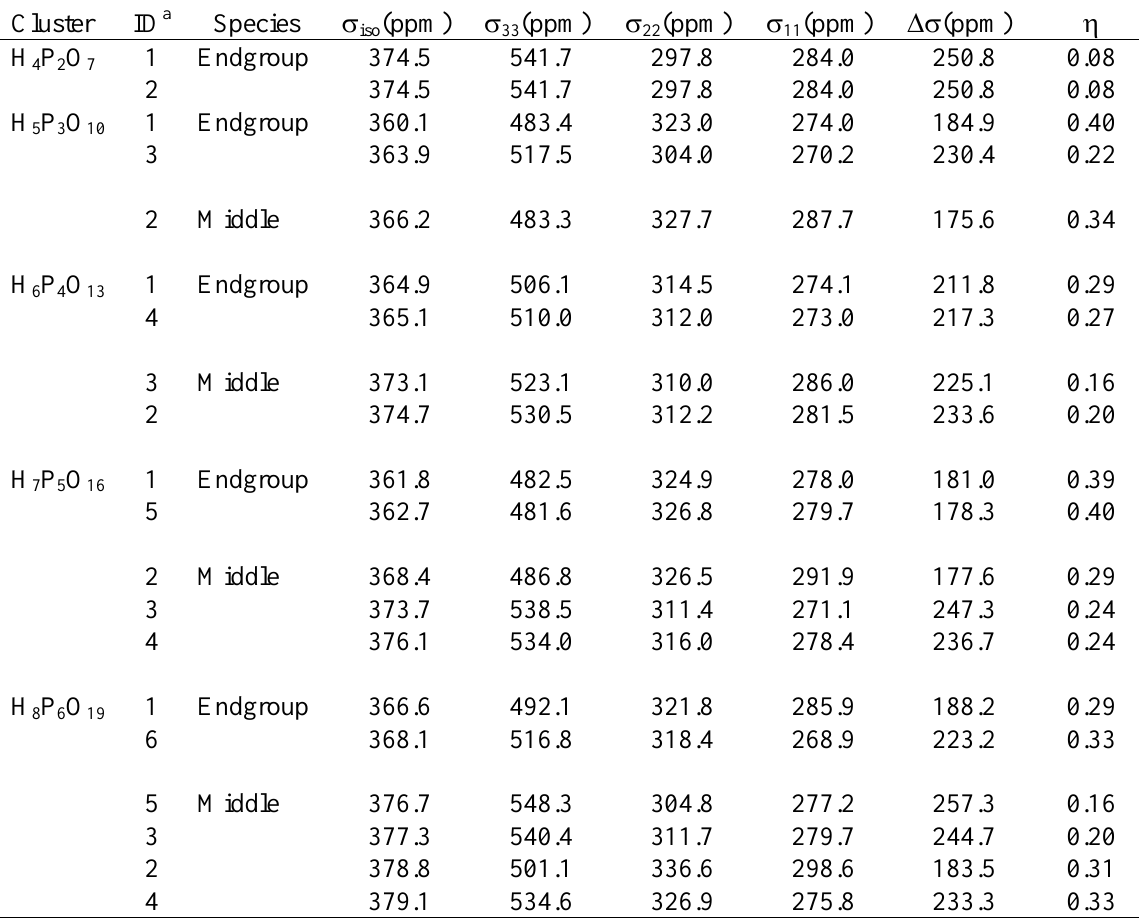
Table 1. Ab Initio NMR 31 P CSA Tensors for Geometry Optimized Acyclic Phosphate Clusters.